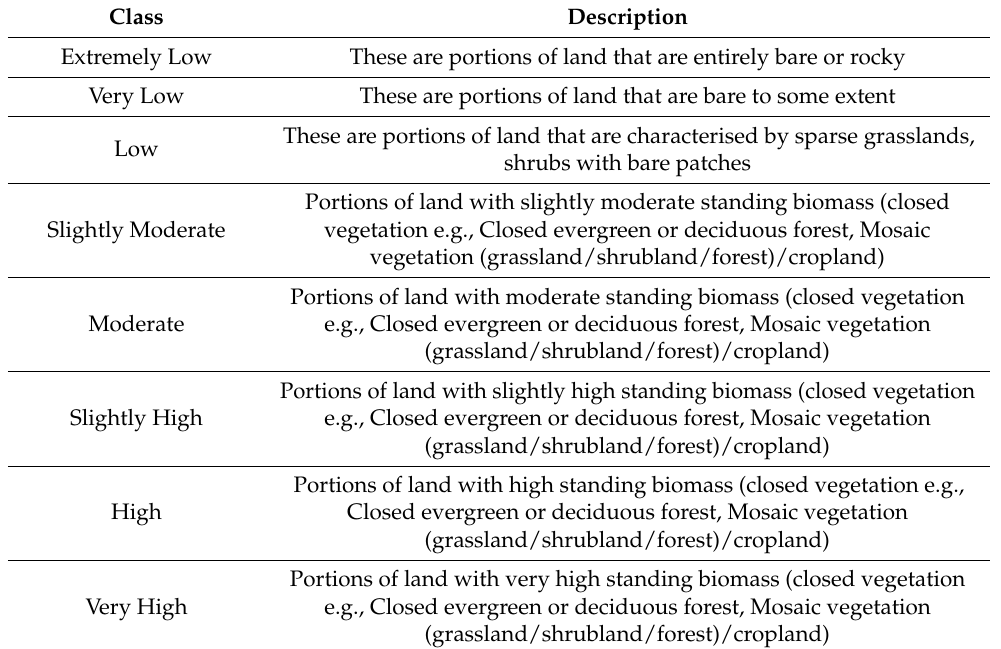
Table 14. Description of the different land productivity classes.